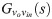
Bode diagram obtained by the theoretical analysis and the circuit simulation with (α, β, γ) = (0.9, 0.9, 0.95) and (α, β, γ) = (0.9, 0.8, 0.95): (a) Gvovin(s); (b) Gvod(s).